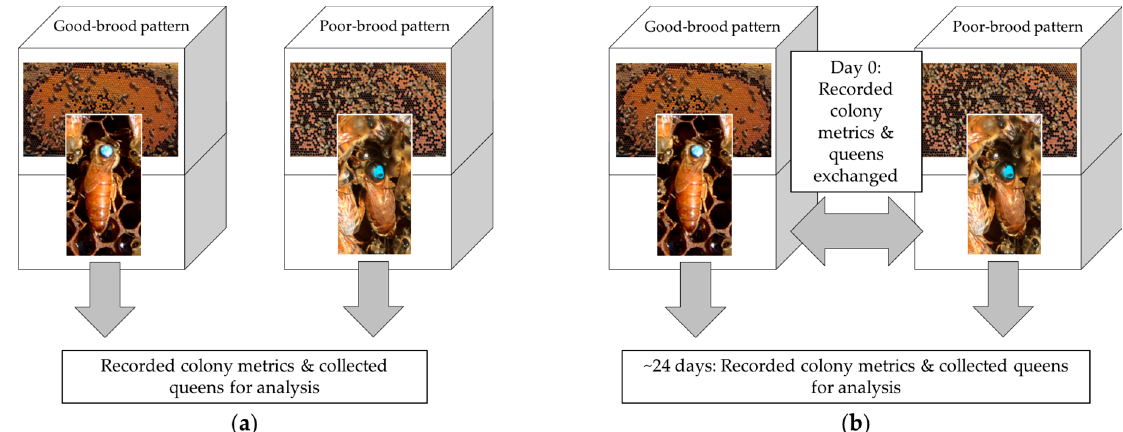
Figure 1. Experimental design. ( a ) In 2016, 17 poor-brood pattern and 17 good-brood pattern colonies were identified, colony metrics recorded, and queens collected and shipped live for analysis. ( b ) In 2017, 21 poor-brood pattern and good-brood pattern colony pairs were identified (42 total colonies), colony metrics recorded, and samples taken. On the same day, queens were exchanged between poor-brood pattern and good-brood pattern colony pairs. In approximately 24 days, colony metrics were again recorded, and queens collected and shipped live for analysis.